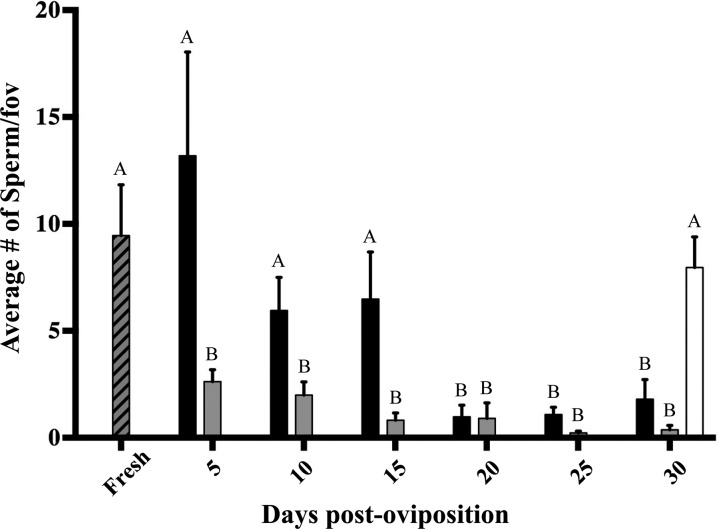
Detection of perivitelline membrane-bound sperm by Hoechst 33342 staining in fresh eggs (grey hatched bar), room-temperature-stored eggs (black bars), incubated (37°C) eggs (grey bars) and refrigerated eggs (white bar). Letters denote significant difference (P < 0.05) in number of sperm between fresh and all other treatments.